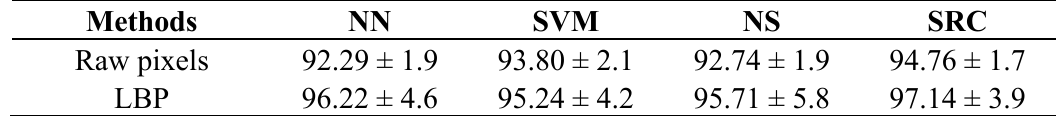
Table 1. Recognition results (%) of different methods with the raw pixels and LBP features.